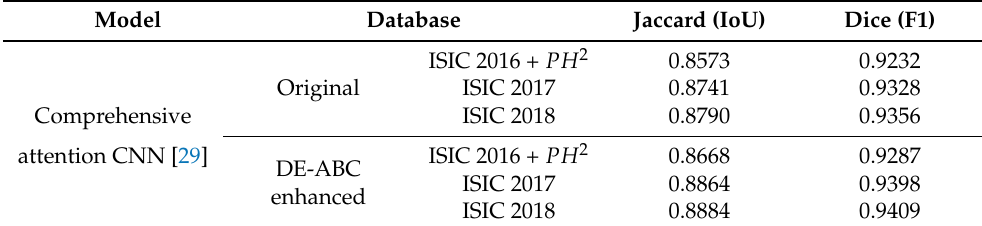
Table 3. Experimental results of comprehensive attention CNN